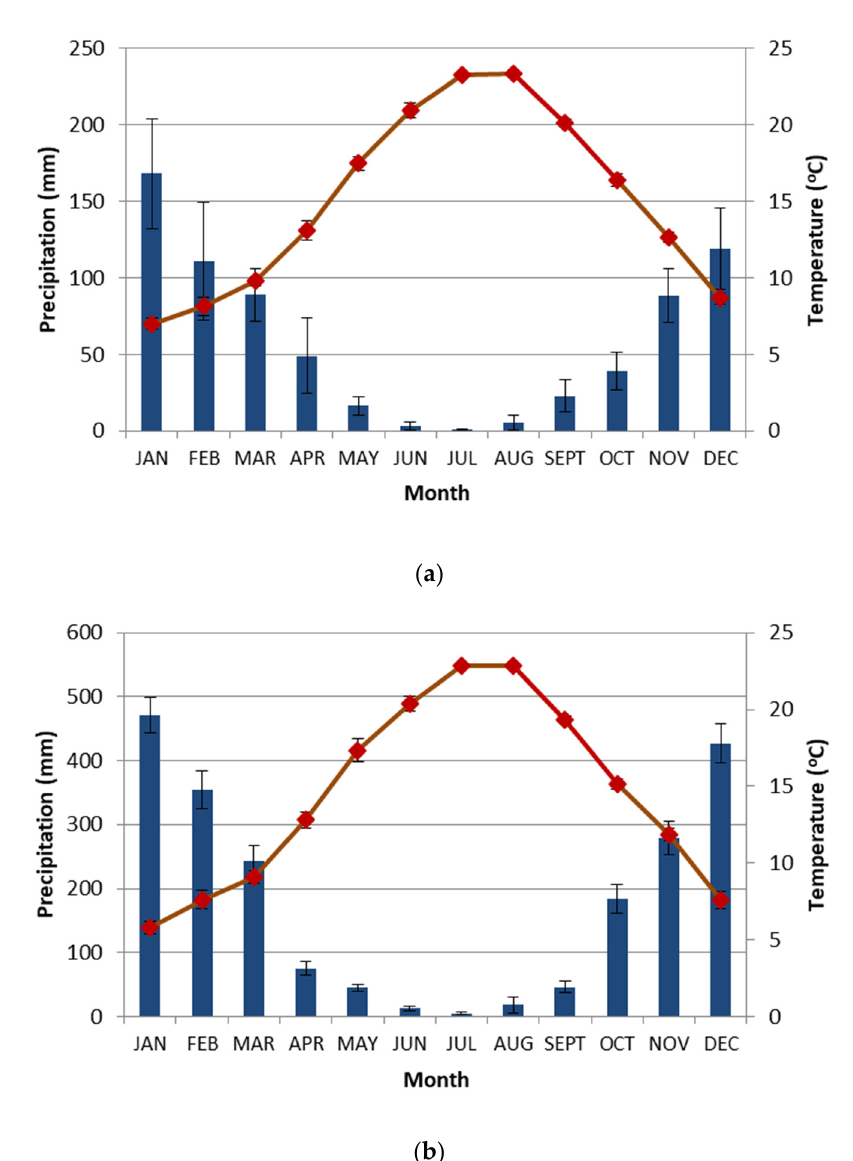
Figure 4. Average monthly precipitation and temperature in ( a ) the west and ( b ) the east mountainous areas of the Municipality of Sfakia. Data were collected from Xyloskalo, Samaria gorge, Askifou and Anopolis stations for the period from 1981 to 2020.